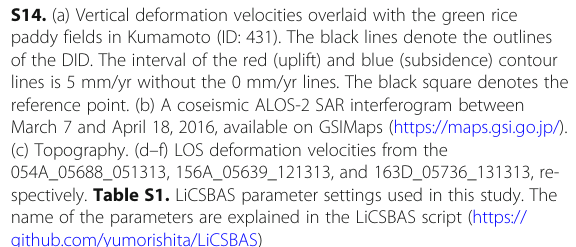
Figure S3. (a) Vertical deformation velocities overlaid with the green rice paddy fields in Kesennuma (ID: 042). The black lines denote the outlines of the DID. The interval of the blue (subsidence) contour lines is 5 mm/yr without the 0 mm/yr lines. The black square denotes the reference point. (b) EW deformation velocities. (c) Topography. (d) LOS deformation time series at P0421 for each frame. Figure S4. Kanto (ID: 131). The black lines denote the outlines of the DID. The interval of the red (uplift) and blue (subsidence) contour lines is 5 mm/yr without the 0 mm/yr lines. The black square around center denotes the reference point. (a) Vertical deformation velocities overlaid with the green rice paddy fields. (b) EW deformation velocities. (c) Topography. (d) LOS deformation velocities from the 039A_05372_151515. (e) LOS deformation velocities from the 141A_05337_160700. (f) LOS deformation velocities from the 046D_05469_071311 and 046D_05292_131313. Figure S5. (a) Vertical deformation velocities overlaid with the green rice paddy fields in Niigata (ID: 151). The black lines denote the outlines of the DID. The interval of the blue (subsidence) contour lines is 5 mm/yr without the 0 mm/yr lines. The black square denotes the reference point. (b) EW deformation velocities. (c) Topography. (d – f) LOS deformation velocities from the 039A_05193_040711, 046D_05292_131313, and 119D_05226_070704, respectively. Figure S6. (a) Vertical deformation velocities overlaid with the green rice paddy fields in Kanazawa (ID: 171). The black lines denote the outlines of the DID. The interval of the red (uplift) and blue (subsidence) contour lines is 5 mm/yr without the 0 mm/yr lines. The black square denotes the reference point. (b) EW deformation velocities. (c) Topography. (d – f) LOS deformation velocities from the 112A_05300_030808, 017D_05353_130400, and 119D_05372_141313, respectively. Figure S7. (a) Vertical deformation velocities overlaid with the green rice paddy fields in Yamagata (ID: 061). The black lines denote the outlines of the DID. The interval of the blue (subsidence) contour lines is 5 mm/yr without the 0 mm/yr lines. The black square denotes the reference point. (b) EW deformation velocities. (c) Topography. (d,e) LOS deformation velocities from the 141A_05118_131311 and 046D_05096_121313, respectively. Figure S8. (a) Vertical deformation velocities overlaid with the green rice paddy fields in Yonezawa (ID: 062). The black lines denote the outlines of the DID. The black square denotes the reference point. (b) EW deformation velocities. (c) Topography. (d – f) LOS deformation velocities from the 039A_05193_040711, 141A_05118_131311, and 046D_05292_131313, respectively. Figure S9. (a) Vertical deformation velocities overlaid with the green rice paddy fields in Ojiya (ID: 155). The black lines denote the outlines of the DID. The interval of the red (uplift) and blue (subsidence) contour lines is 5 mm/yr without the 0 mm/yr lines. The black square denotes the reference point. (b) EW deformation velocities. (c) Topography. (d – f) LOS deformation velocities from the 039A_05372_151515, 046D_05292_131313, and 119D_05226_070704, respectively. Figure S10. (a) Masked vertical deformation velocities in Hirosaki (ID: 022). The black lines denote the outlines of the DID. The interval of the red (uplift) and blue (subsidence) contour lines is 5 mm/yr without the 0 mm/yr lines. The black square denotes the reference point. (b) Unmasked vertical deformation velocities overlaid with the green rice paddy fields. (c) Topography. Figure S11. (a) Vertical deformation velocities overlaid with the green rice paddy fields in Sanjo (ID: 153). The black lines denote the outlines of the DID. The interval of the blue (subsidence) contour lines is 5 mm/yr without the 0 mm/yr lines. The black square denotes the reference point. (b) EW deformation velocities. (c) Topography. (d – f) LOS deformation velocities from the 039A_05193_040711, 046D_05292_131313, and 119D_05226_070704, respectively. Figure S12. (a) Vertical deformation velocities overlaid with the green rice paddy fields in Nara (ID: 291). The black lines denote the outlines of the DID. The interval of the red (uplift) and blue (subsidence) contour lines is 5 mm/yr without the 0 mm/yr lines. The black square denotes the reference point. (b) Topography. (c,d) LOS deformation velocities from the 010A_05549_121311 and 017D_05514_131312, respectively. Figure S13. (a) Vertical deformation velocities overlaid with the green rice paddy fields in Osaka (ID: 271). The black lines denote the outlines of the DID. The interval of the red (uplift) and blue (subsidence) contour lines is 5 mm/yr without the 0 mm/yr lines. The black square denotes the reference point. (b) Topography. (c,d) LOS deformation velocities from the 010A_05549_121311 and 017D_05514_131312, respectively. Figure